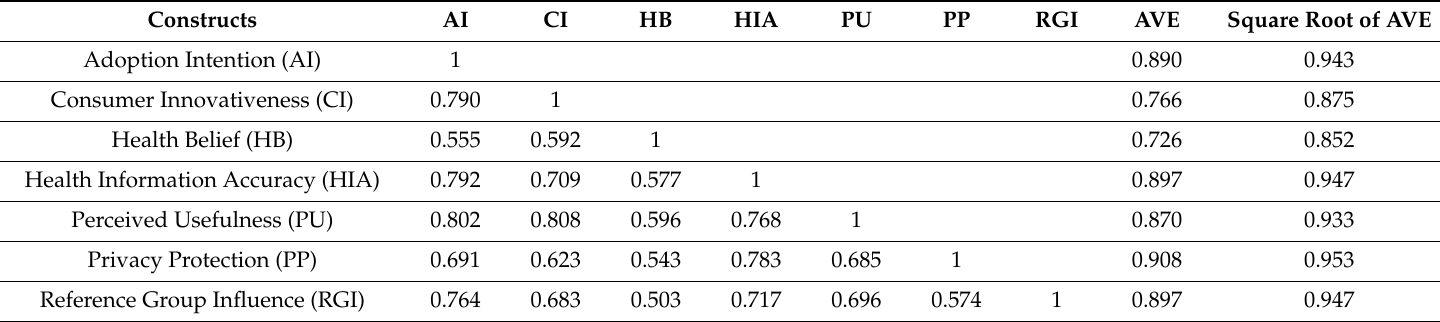
Table 2. Construct correlation matrix and average variance extracted